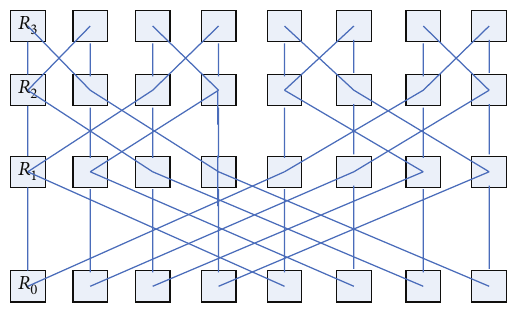
Figure 3: Three-node butterfly network routing plans.